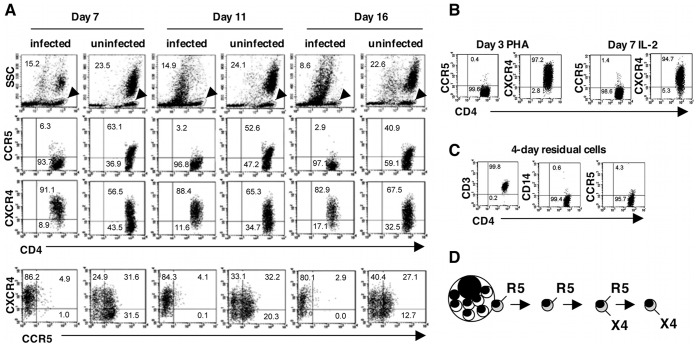
CCR5 and CXCR4 expression on CD4+ T-cells in HIV-1 infected and uninfected MDM cultures.(A) HIV-1 infection leads to preferential loss of CCR5+ CD4+ T-cells. Populations shown were gated based on low side scatter and CD4 expression. The circumscribed gated cells, identified by arrowheads, are shown in the upper left panels for each time point. MDM cultures were infected with HIV-1 Ba-L and the nonadherent cells harvested for analysis using flow cytometry. (B) The CD4+ T-cells present in PHA-stimulated cultures of normal donor PBMC are CCR5 negative and CXCR4+. This is also the case for CD4+ T-cells stimulated with PHA for 3 days, and then cultured in the presence of IL-2 for an additional 7 days. (C) CCR5 expression is also lacking on residual CD4+ T-cells harvested from uninfected macrophage cultures established from seeded PBMC. (D) Scheme for developmental stages of CCR5 and CXCR4 expression on nurse macrophage-derived CD4+ T-cells.